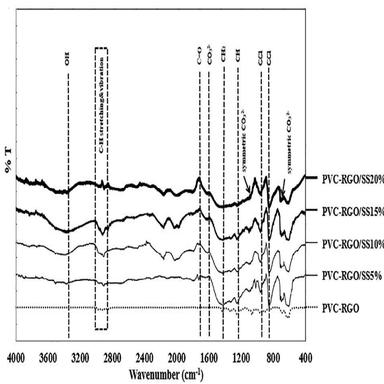
The FTIR spectra of PVC-RGO composite and SS reinforced PVC-RGO biocomposites.